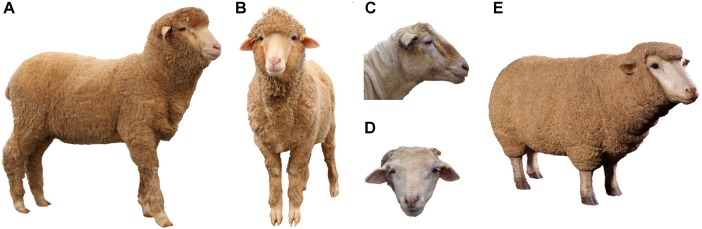
Alternative stimuli trialed during the pilot study. Stimuli included photographs of entire sheep from the side (A) and front (B), photographs of faces only from the side (C) and front (D) and a three-dimensional fiberglass model of a sheep (E). All stimuli were approximately life-size.